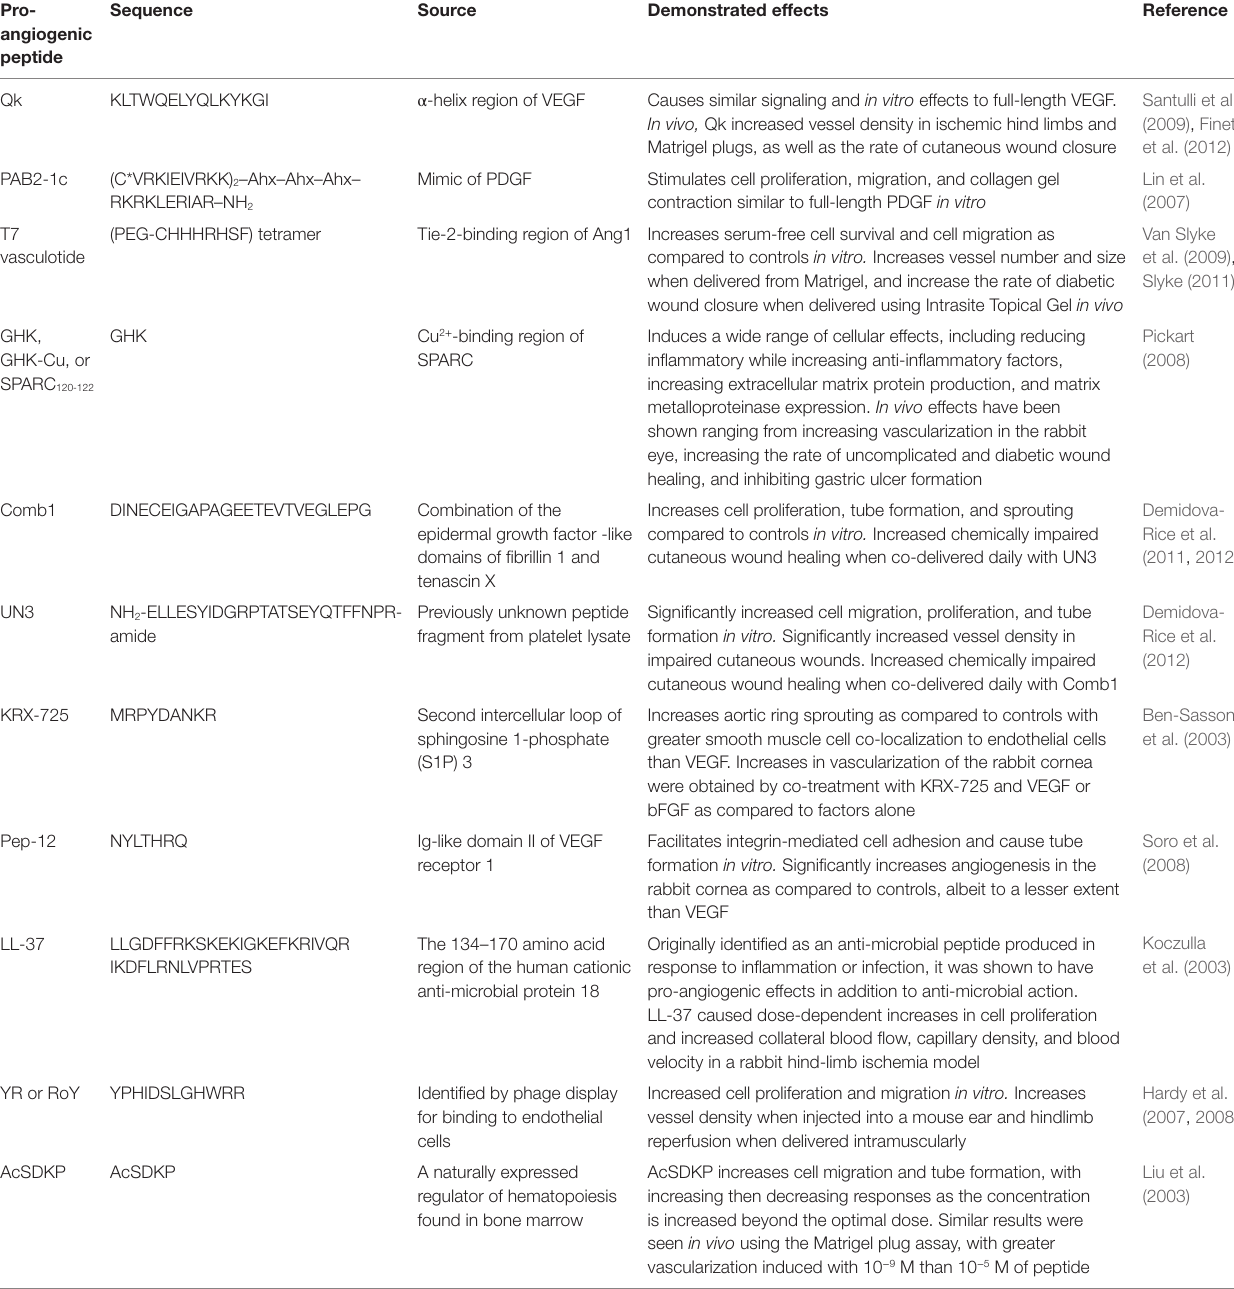
TABLe 2 | Pro-angiogenic peptides. Pro-